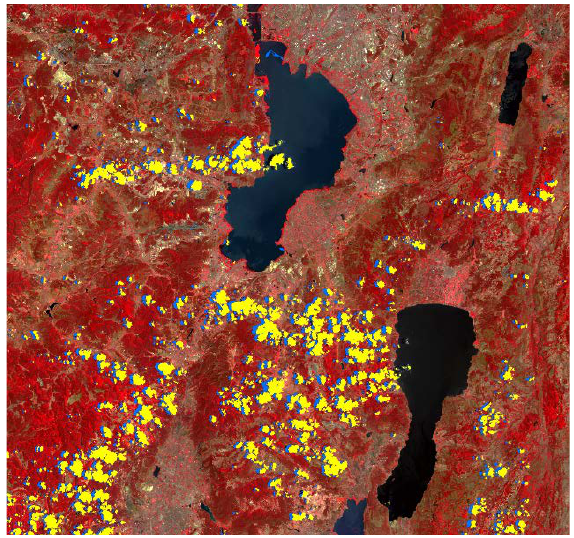
Figure3.Cloud and shadow extraction results Accuracy